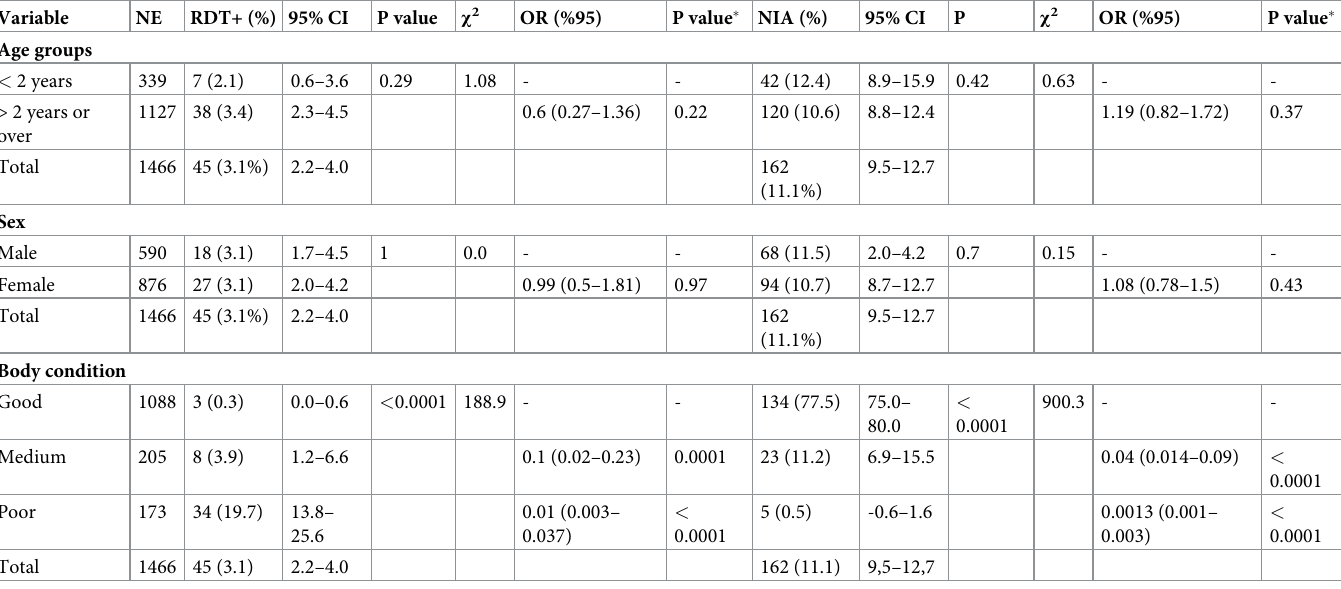
Table 2. Positivity of RDTs and prevalence of trypanosome infections according to age groups, sex and body condition of